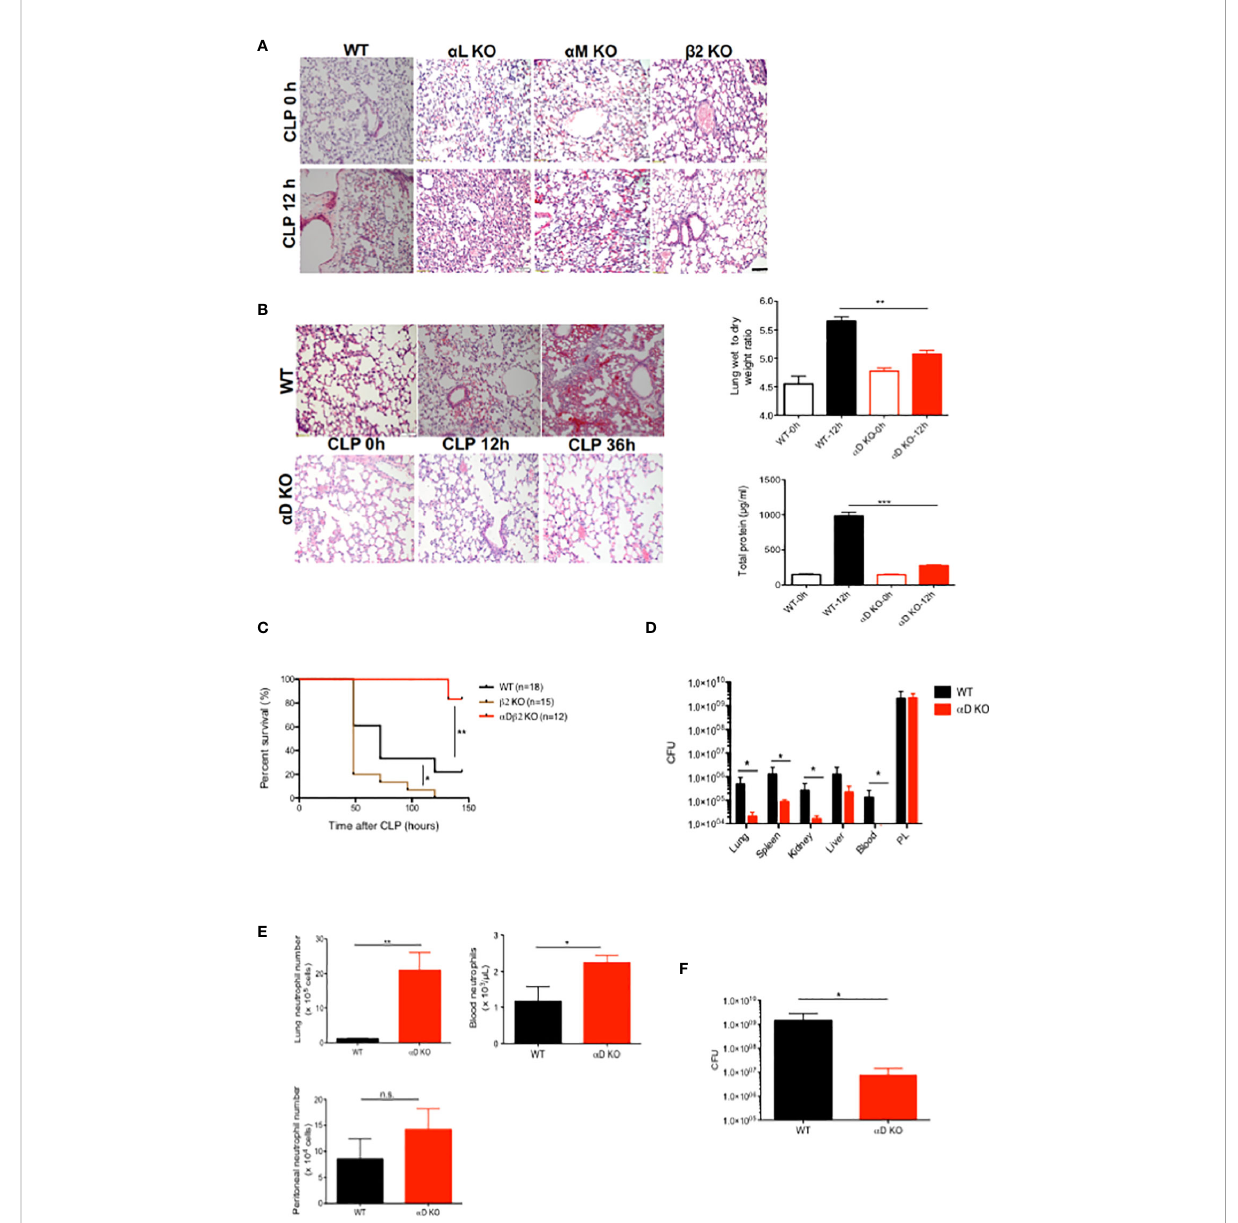
FIGURE 1 The role of a D b 2 in sepsis. (A) Representative lung histology of WT, a L KO, a KO, and b 2 KO mice at the baseline and at 12 hours after CLP. Black bar indicates 50 µm. (B) Representative lung histology of WT and a D KO at the baseline, at 12 and 36 hours after CLP. Wet to lung analysis and BAL total protein analysis at the baseline and at 12 hours after CLP. Data were shown as mean +/- S.D. of 6 mice per group. One-way ANOVA with Bonferroni post hoc analysis was performed. **p < 0.01, ***p < 0.001. (C) Survival after CLP in WT (n=18), a D KO (n=12) and b 2 KO (n=15) mice. Cox regression analysis was performed. *p <0.05, **p <0.01. (D) Bacterial loads in WT and a D KO mice at 12 hours after CLP. Data were shown as mean +/- S.D. of 8 mice per group. Two-way ANOVA analysis was performed. *p < 0.05. (E) Neutrophil counts at the lungs, the blood, and the peritoneal cavity in WT and a D KO mice at 12 hours after CLP. Data were shown as mean +/- S.D. of 6 mice. Student t test was performed. *P < 0.05, p < 0.01. (F) Bacterial loads at the peritoneal cavity at 6 hours after E coli intraperitoneal injection. Data were shown as mean +/- S.D. of 6 mice. Student t test was performed. *p <